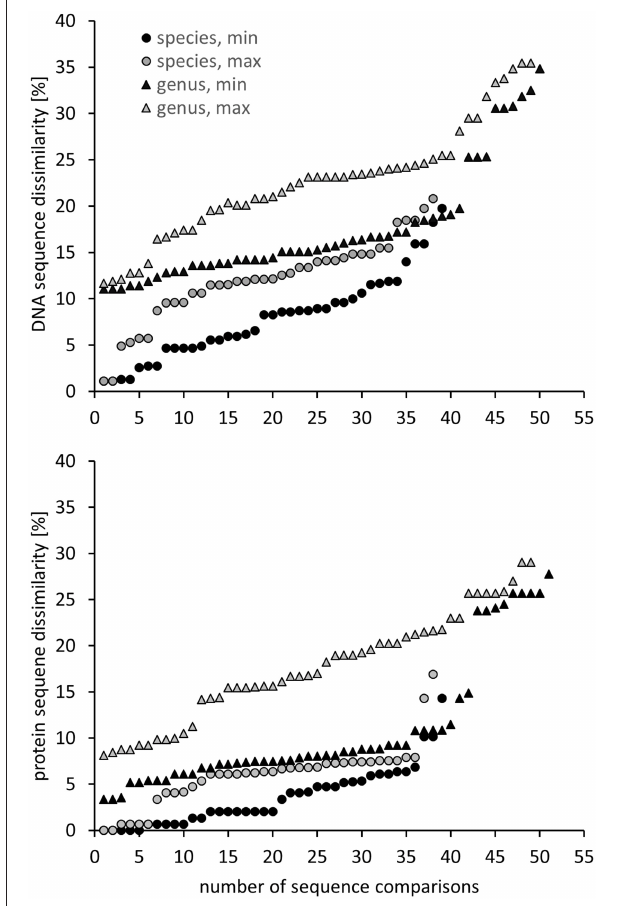
FIGURE 2 | Minimum and maximum pmoA sequence dissimilarity at DNA (upper panel) and protein level (lower panel) between a type strain and its most closely and most distantly related type strain within the same species, as well as to the most closely and distantly related type strain of a different genus within the same family or type (according to Table 1). DNA and protein distance matrices were calculated in ARB based on 480 aligned nucleotide positions or 160 deduced amino acid positions. Methylomicrobium album and Methylomicrobium agile were not included, due to the very distant clustering from the other Methylomicrobium strains ( Figure 1 ), while “ Candidatus Crenothrix polyspora” was excluded due to the fact that it contains a highly divergent pmoA sequence compared to all other Gammaproteobacteria